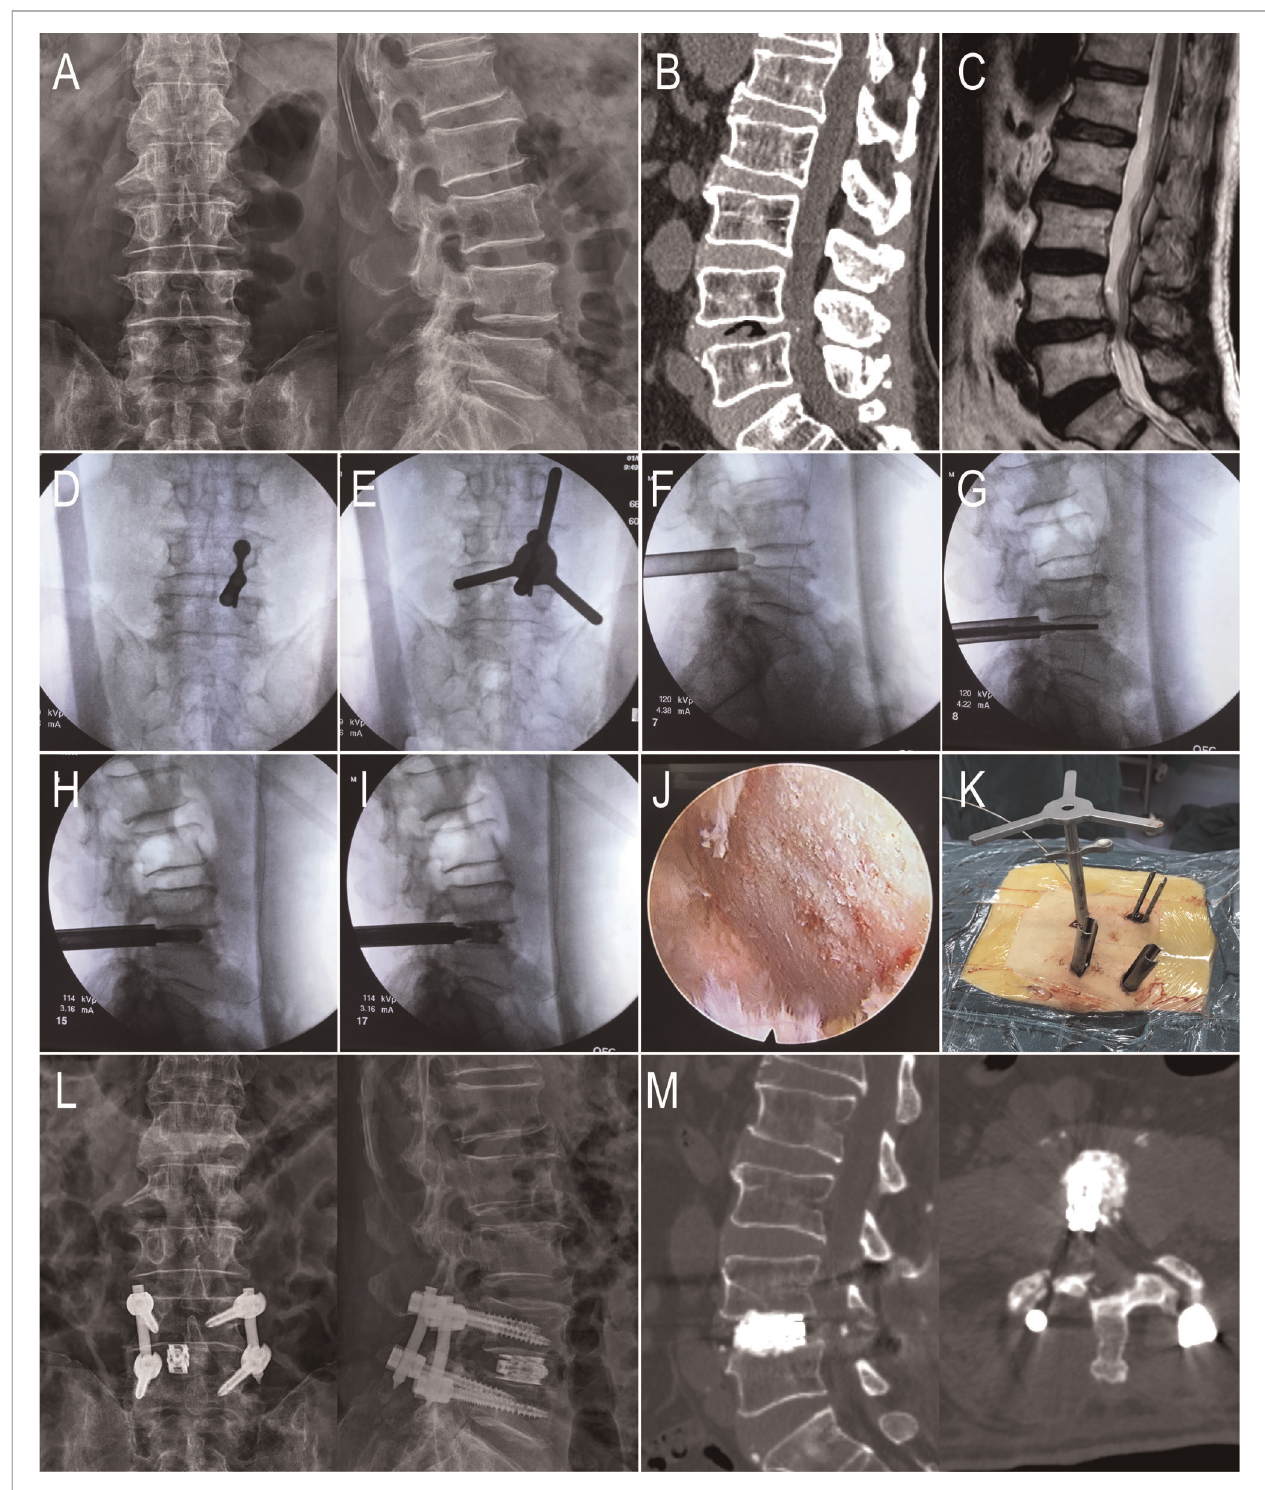
FIGURE 1 | An 81-year-old male with L4-5 LSS in the PE-LIF group. ( A – C ) Preoperative X-ray, CT, and MRI showed that L4 and L5 vertebra body and the intervertebral; ( D ) The puncture needle was placed; ( E ) Using the circular saw to remove a part of the facet joint; ( F ) the working cannula were placed percutaneously; ( G,H ) using reamers of different diameters to mince the intervertebral disc tissues and conduct endplate preparation; ( I ) the titanium expandable cage was placed through the working cannula; ( J ) Decompression of the nerve root and handling the endplates under endoscopic vision ( K ) Direct vision of the working channel and the circular saw. (L-M) X-ray and CT showed the percutaneous pedicle screw fi xation and the titanium expandable cage.